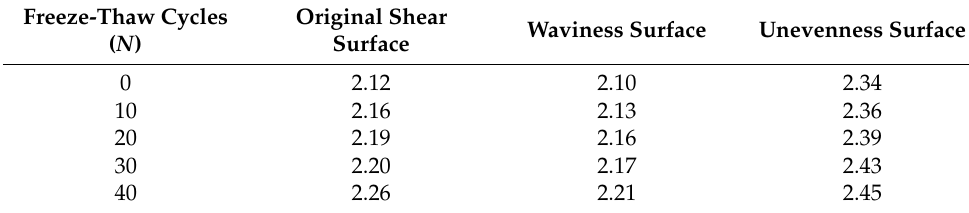
Figure 5. The three-dimensional topography of the shear surface before and after Gaussian filtering of the unfreeze-thaw jointed rock specimen. ( a ) The original shear surface after the first shear experiment. ( b ) Joint waviness surface after Gaussian filtering. ( c ) Joint roughness surface after Gaussian filtering. Table 1. Fractal dimension of the shear surface before and after Gauss filtration in the first shear test. Freeze-Thaw